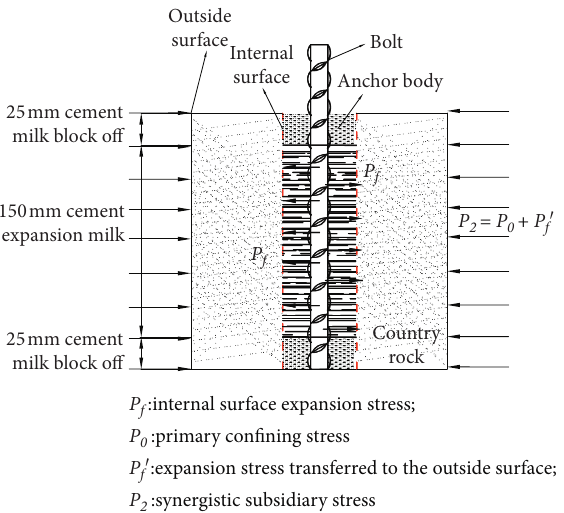
Figure 6: Schematic diagram of pouring anchors.